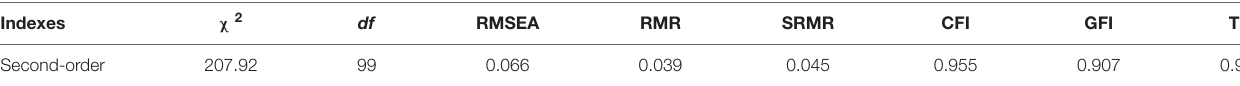
TABLE 3 | Goodness-of-fit indexes for five-factor model using the second-order